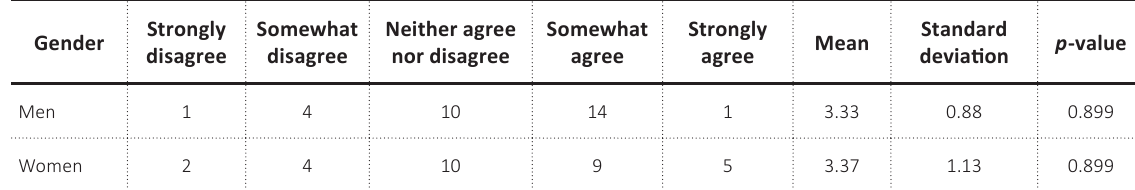
Table 4. My job is enjoyable